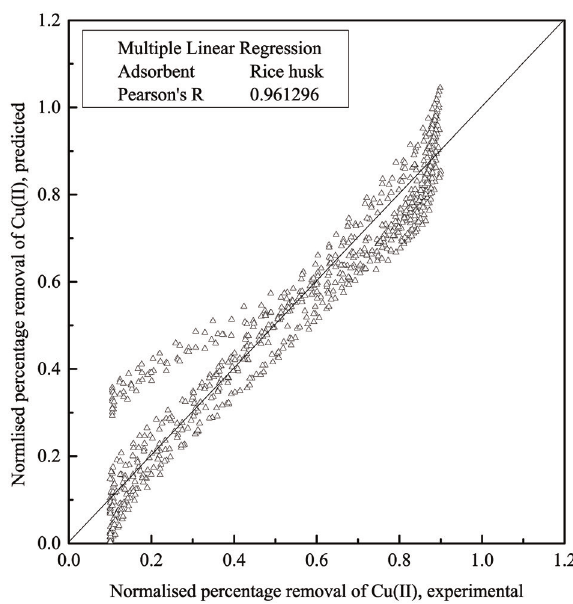
Figure 9. MLR plot for rice husk used as adsorbent